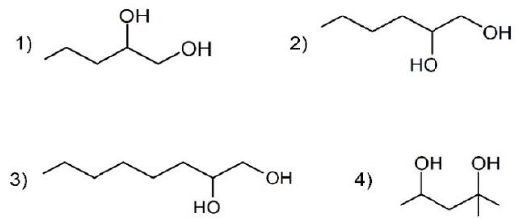
Figure 1. Chemical structures of the alkanediols used: (1) 1,2-pentanediol, (2) 1,2-hexanediol, (3) 1,2-octanediol, (4) 2-methyl-2,4-pentanediol.